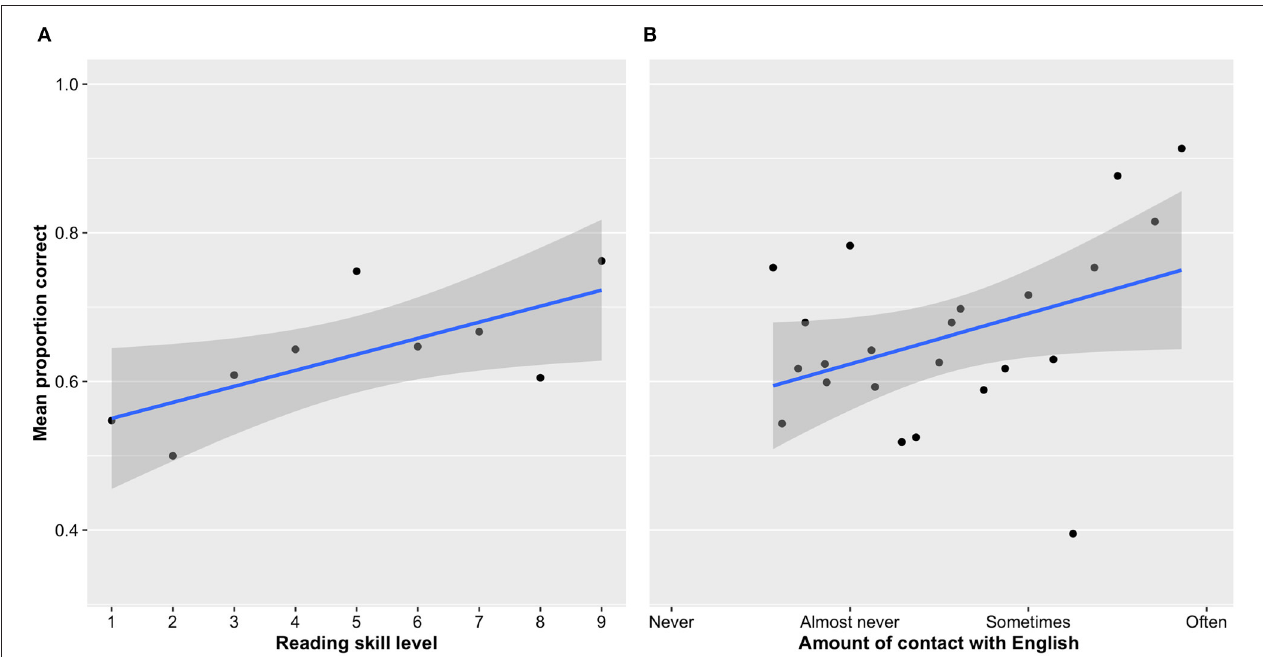
FIGURE 5 | The shaded areas represent the 95% confidence interval. (A) Effect of reading skill level on accuracy during learning. Skilled readers learned more words in the multiple-choice task. The dots represent the average proportion of words remembered for all the children within a given level of reading skill (B) Effect of knowledge of English on accuracy during learning. Children who had more previous knowledge of English learned more words during the multiple-choice learning task. The dots represent the average proportion of words remembered for all the children within a certain level of English knowledge.